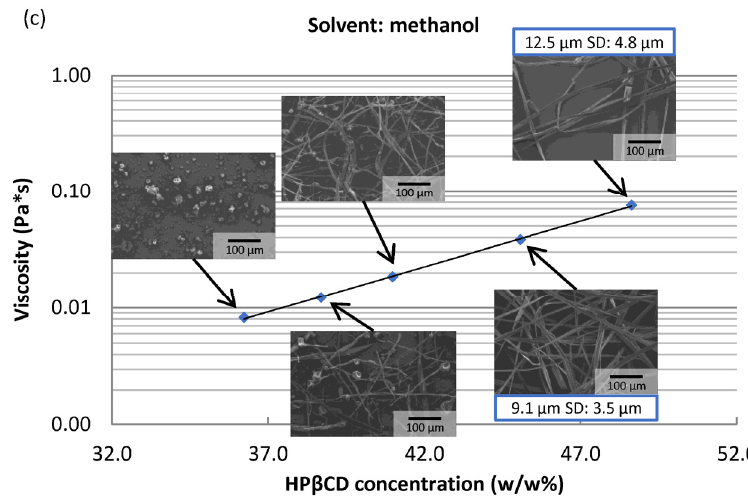
Figure 1. Viscosity of HP β CD solutions and the morphology of the obtained fibers prepared by SNES using ( a ) water, ( b ) methanol/water (1:1), ( c ) methanol as a solvent. D = average fiber diameter.